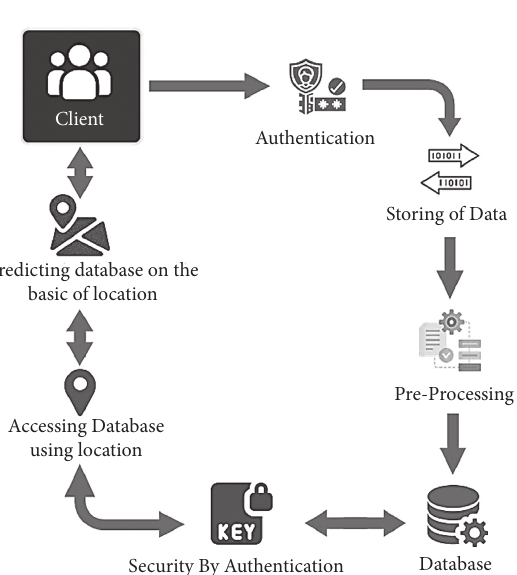
Figure 10: Location prediction